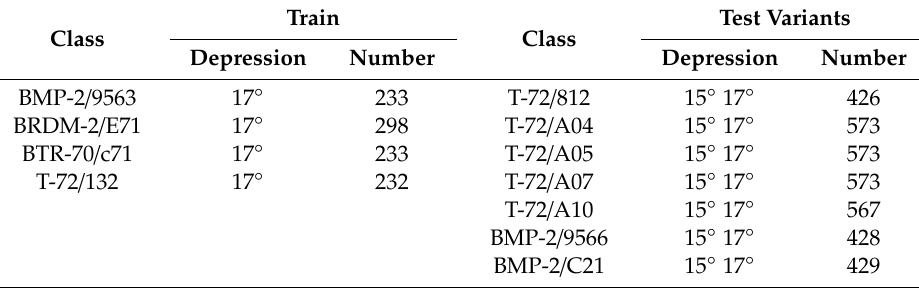
Table 4. Number of training and test samples for EOC-2 (version